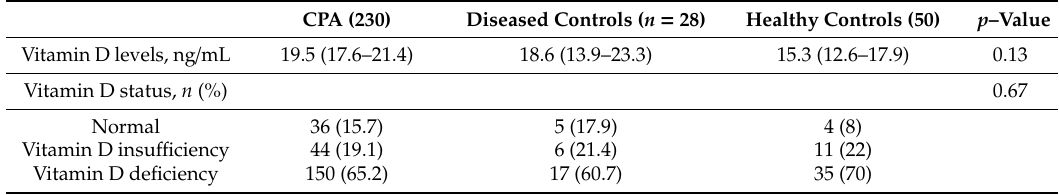
Table 2. Vitamin D characteristics in the study